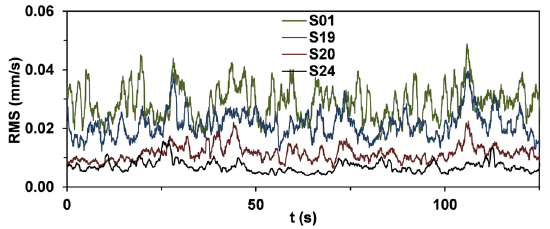
Figure 9. RMSs of recording velocities in configuration C3.